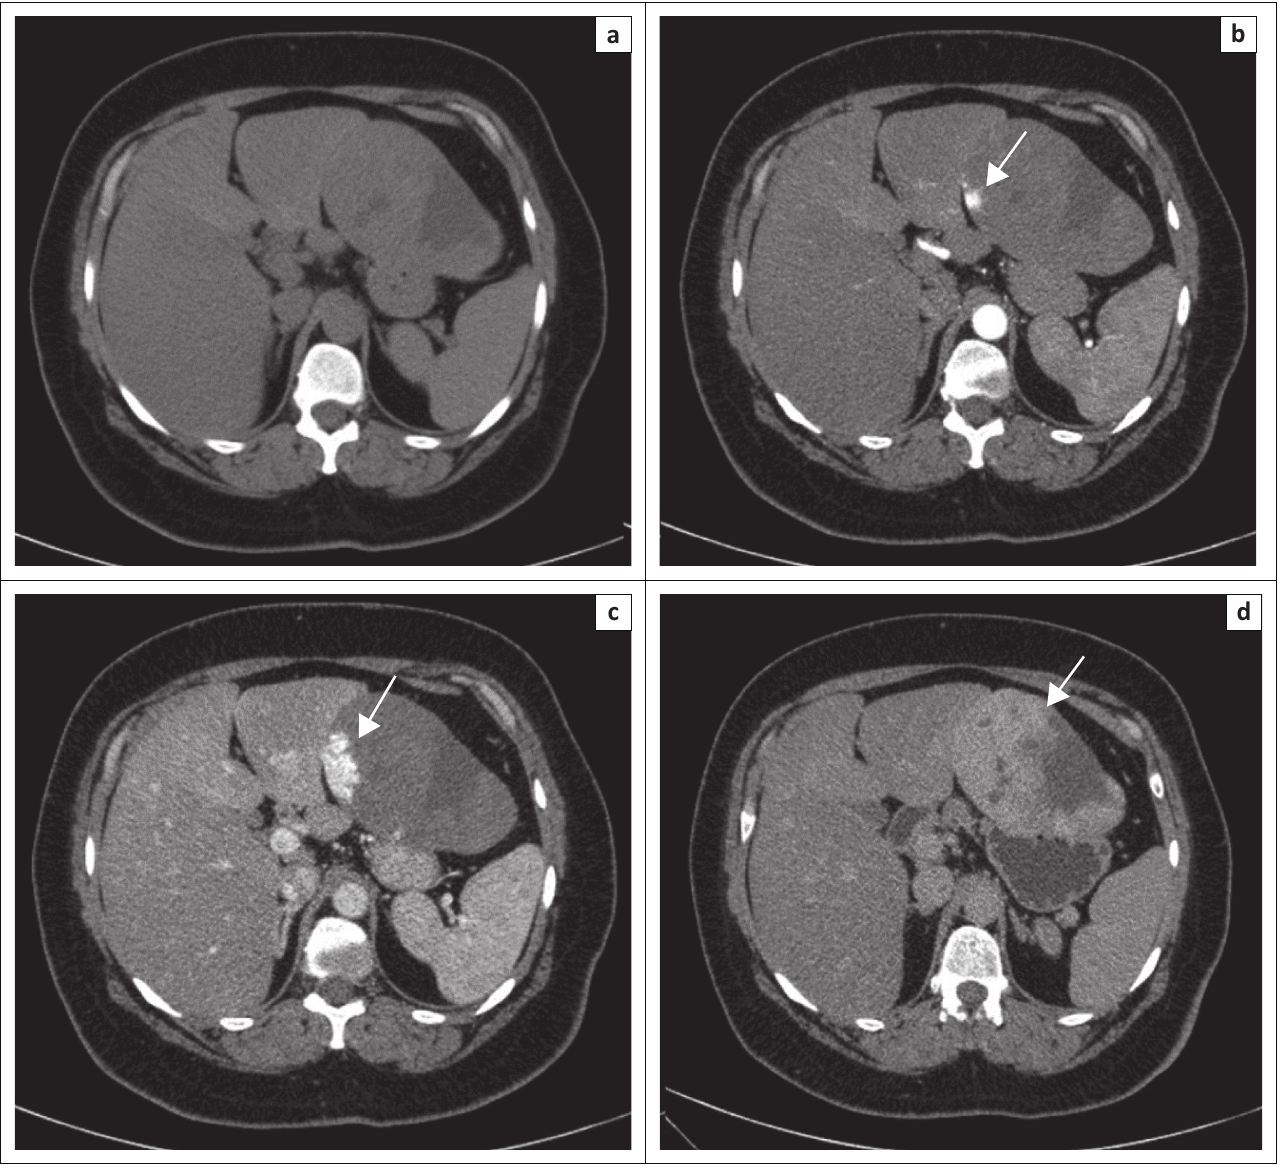
FIGURE 1: Non-contrast computed tomography scan (a) showing a mass lesion which appears separated from the liver and is causing scalloping of the left lobe, closely abutting the lesser curvature of the stomach and appearing inseparable from it. Post-contrast arterial phase (b) shows patchy peripheral enhancement adjacent to the left lobe of the liver (arrow). Portovenous (c) and delayed (d) phases show progressive filling in of the lesion with contrast (arrows). The pattern of enhancement is suggestive of a